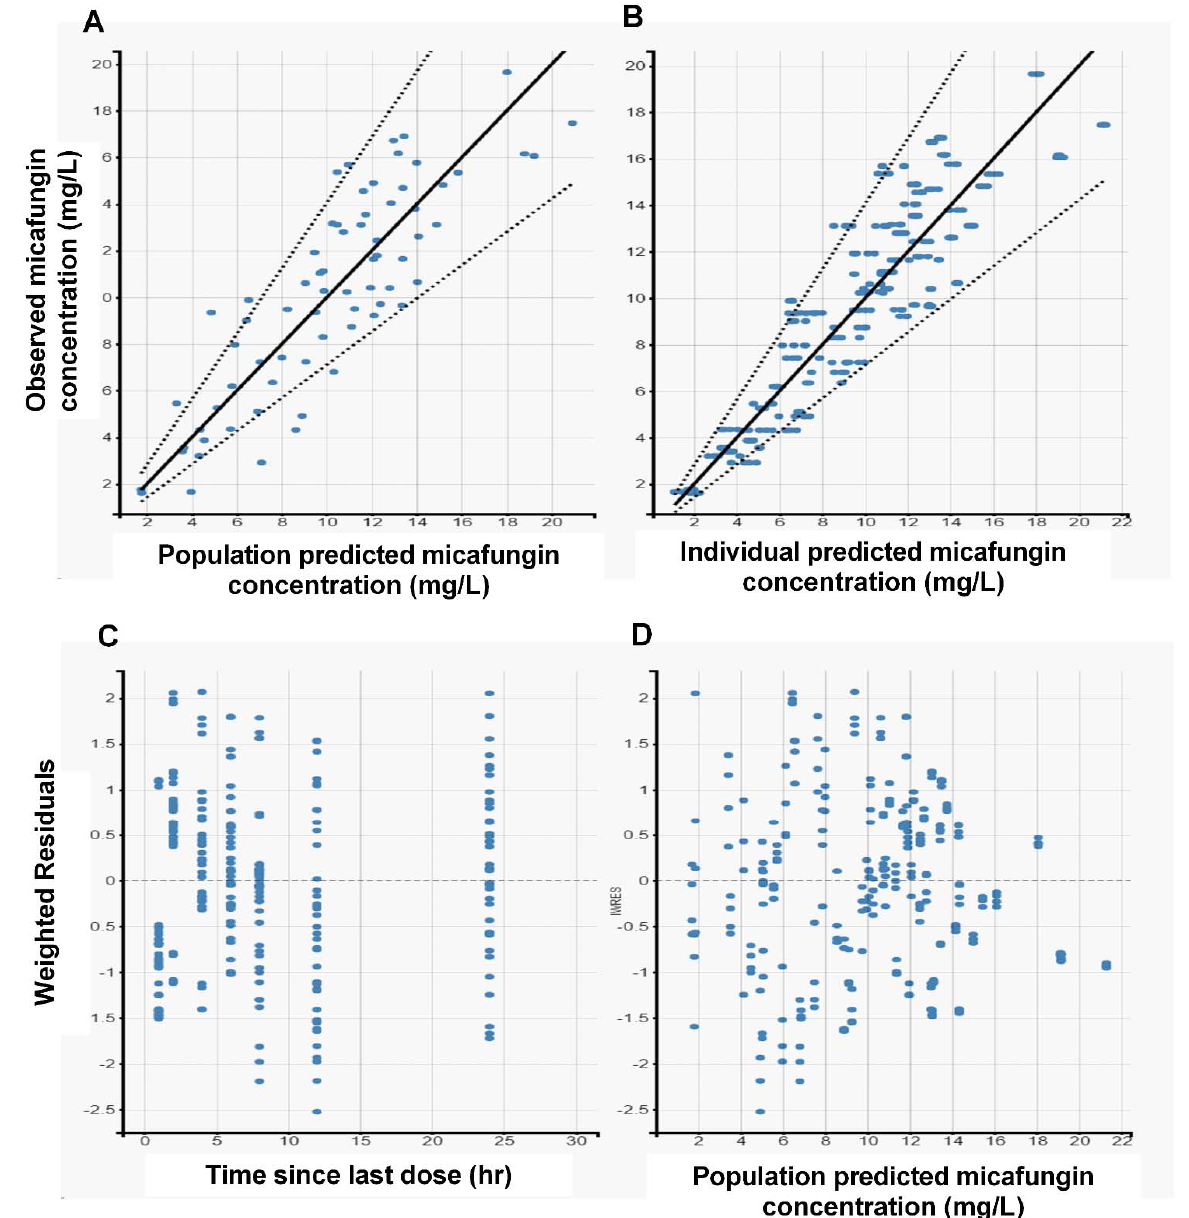
Figure 1. Goodness − of − fit (GOF) plots obtained from the final model for micafungin. ( A ) Individual predictions of micafungin vs. observed concentrations. ( B ) Population predictions of micafungin vs. observed concentrations. ( C ) Weighted residuals vs. time since last dose. ( D ) Weighted residuals vs. population predicted concentrations.